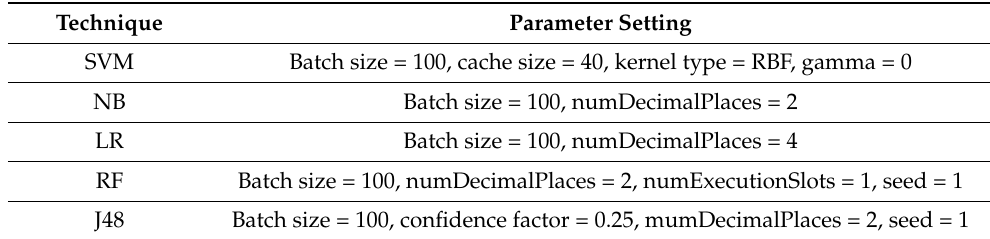
Table 3. Parameters of the data mining techniques.